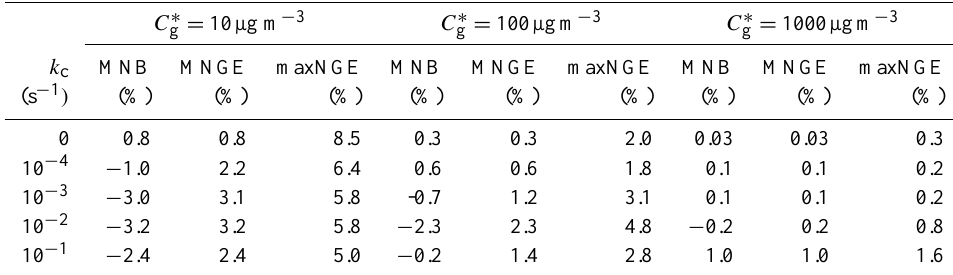
Figure 10. Comparison of MOSAIC (lines) and finite-difference model (filled circles) solutions for gas-phase concentration evolution in a general system due to kinetic gas-particle partitioning to particles with initial D p = 0.2µm, N = 5000cm − 3 , D b = 10 − 15 cm 2 s − 1 , γ = 0.1µgm − 3 h − 1 , and k c ranging from 0 to 0.1s − 1 for three solute volatilities: (a) C ∗ g = 10µgm − 3 , (b) C ∗ g = 100µgm − 3 , and (c) C ∗ g = 1000µgm − 3 . Table 2. Bias and error statistics for MOSAIC predictions for the general system